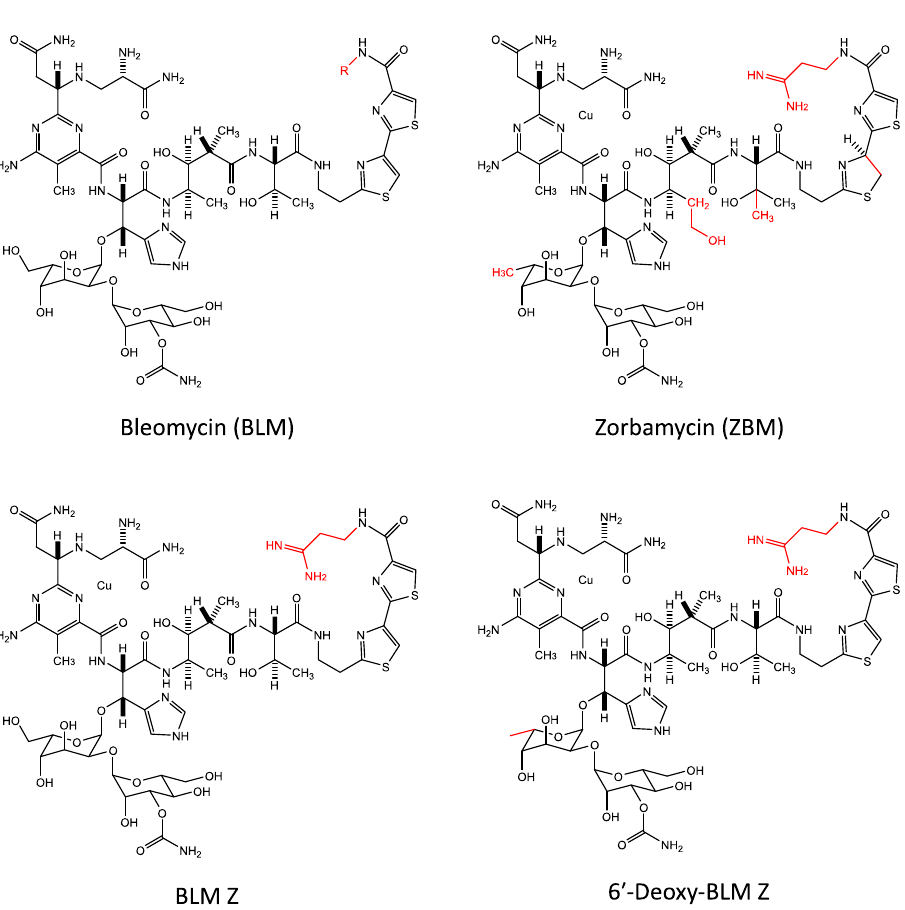
Figure 6. The chemical structures of bleomycin, 6 ′ -deoxy-BLM Z, BLM Z, and ZBM. Differences in chemical structures are shown in red.